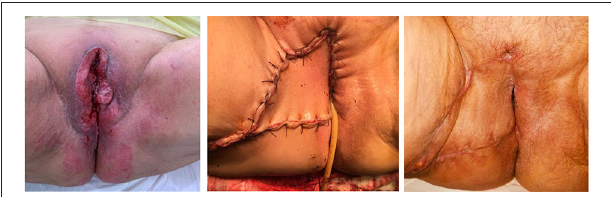
TABLE 1 | Patients’ characteristics.